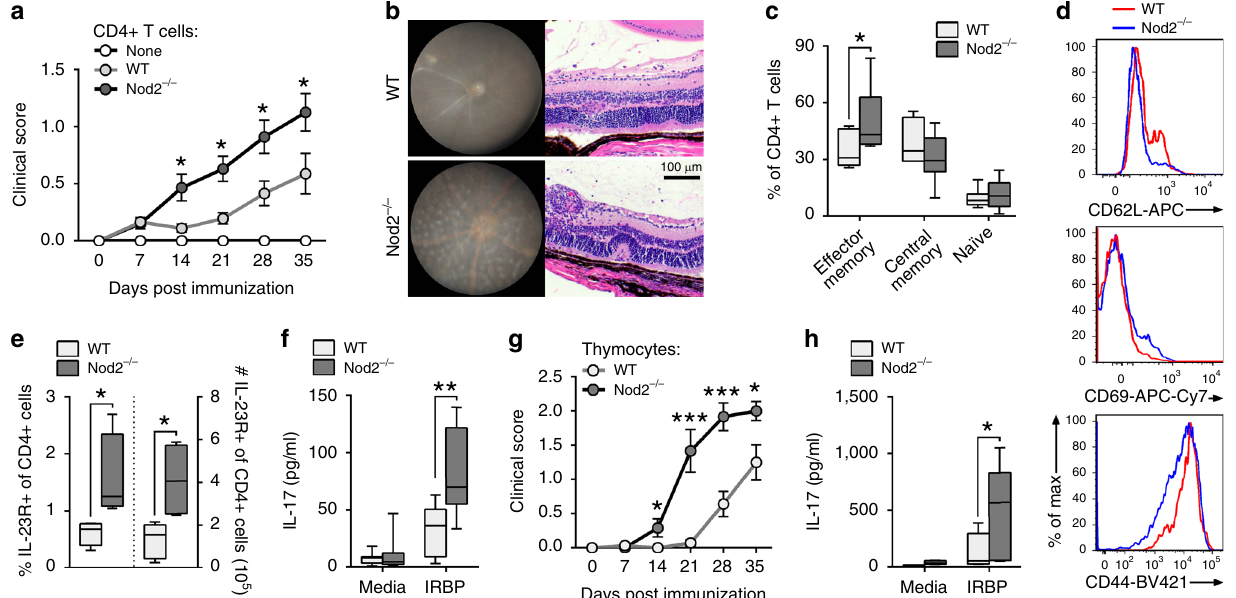
Fig. 5 Nod2 inhibition of Th17-mediated uveitis is T cell-intrinsic. Rag1 − / − mice were reconstituted with CD4 + T cells from naïve WT or Nod2 − / − mice and immunized 1 day later ( a – f ). a Clinical uveitis was evaluated weekly by fundoscopy after immunization. Data is combined from 6 independent experiments and (from left to right), n = 43, 40, 38, 24, 17 (WT) and n = 30, 46, 46, 28, 12 (Nod2 − / − ) mice; * p = 0.0275 (14 day), * p = 0.0160 (21 day), * p = 0.0216 (28 day), * p = 0.0232 (35 day). b Images of fundus and H&E-stained retinal sections 35 days post-immunization. Splenocytes harvested 35 days post-immunization were analyzed by fl ow cytometry ( c – e ) or ELISA ( f ). c Frequencies of effector memory (CD62L lo CD44 mid ), central memory (CD62L lo CD44 hi ), and naïve CD4 + T cells (CD62L hi CD44 lo ). Data are combined from 2 independent experiments for n = 7 (WT) and 9 (Nod2 − / − ); * p = 0.0418. d Cell surface expression of CD62L, CD69, and CD44 on CD4 + T cells, and ( e ) frequency and total number of CD4 + T cells expressing IL-23R recovered from spleens of IRBP-immunized Rag1 − / − recipients. Data are combined from 2 independently performed experiments with n = 5 (WT) and n = 4 (Nod2 -/- ) mice; * p = 0.0159 (% and #). f IL-17 production was measured by ELISA following 18 h in vitro stimulation with IRBP 1 – 20 . Data are combined from 2 independent experiments. For WT, n = 10 (media) and 9 (peptide) and for Nod2 − / − , n = 11(media) and 10 (peptide) mice; ** p = 0.0030. ( g - h ) Rag1 − / − mice were reconstituted with thymocytes derived from naïve WT or Nod2 − / − mice and immunized with IRBP 8 days later. g Clinical uveitis was evaluated weekly by fundoscopy. Data is combined from 2 independent experiments. For WT, n = 14 (7, 14, 21, 35 day), 13 (28 day) and for Nod2 − / − , n = 12 mice; * p = 0.0331 (14 day), *** p < 0.0001 (21 day), *** p = 0.0002 (28 day), * p = 0.0347 (35 day). h IL-17 production was measured with ELISA following 18 h in vitro stimulation of splenocytes with IRBP 1 – 20 . Data are combined from 2 independent experiments with n = 9 (WT media) and 8 (all other conditions) mice; * p = 0.0281. Data are mean ± SEM ( a , g ), box-whisker plots showing median, 25 – 75th percentile and min-max range ( c , f ), or box- whisker plots showing median, 10 – 90th percentile and min-max ( e , h ). Statistical differences between groups were calculated using two-tailed Mann – Whitney U test. Source data are provided as a Source Data fi response between antigen recognition and Nod2 expression (Fig. 7a). To examine how Nod2 expression alters antigen-speci fi c TCR function in vivo, we crossed IRBP TCR-Tg mice (i.e., R161M mice on the B10.RIII background 33 ) with Nod2 − / − mice (on B10.RIII background) to generate Nod2 − / − R161M mice. In R161M mice, the CD4 + T cells recognize IRBP via a transgenic αβ TCR and develop spontaneous uveitis without immunization. Importantly, their T cells are capable of inducing uveitis after Fig. 5. After immunization of Rag1 − / − recipients, the transferred adoptive transfer into lymphopenic recipients (i.e., without prior Rip2 − / − thymocytes (which have similar composition to WT mice 32 ) elicited signi fi cantly less severe uveitis compared to WT in vitro activation) 33 . CD4 + T cells puri fi ed from naïve R161M thymocytes (Fig. 6c, d), indicating an inherent and opposing mice or Nod2 − / − R161M mice were transferred into naïve syn- geneic B10.RIII Rag2 − / − mice that were monitored for develop- T cellular function for Rip2 in pathogenesis of uveitis. Collectively ment of uveitis (Fig. 7b, c). Recipients of Nod2 − / − R161M CD4 +